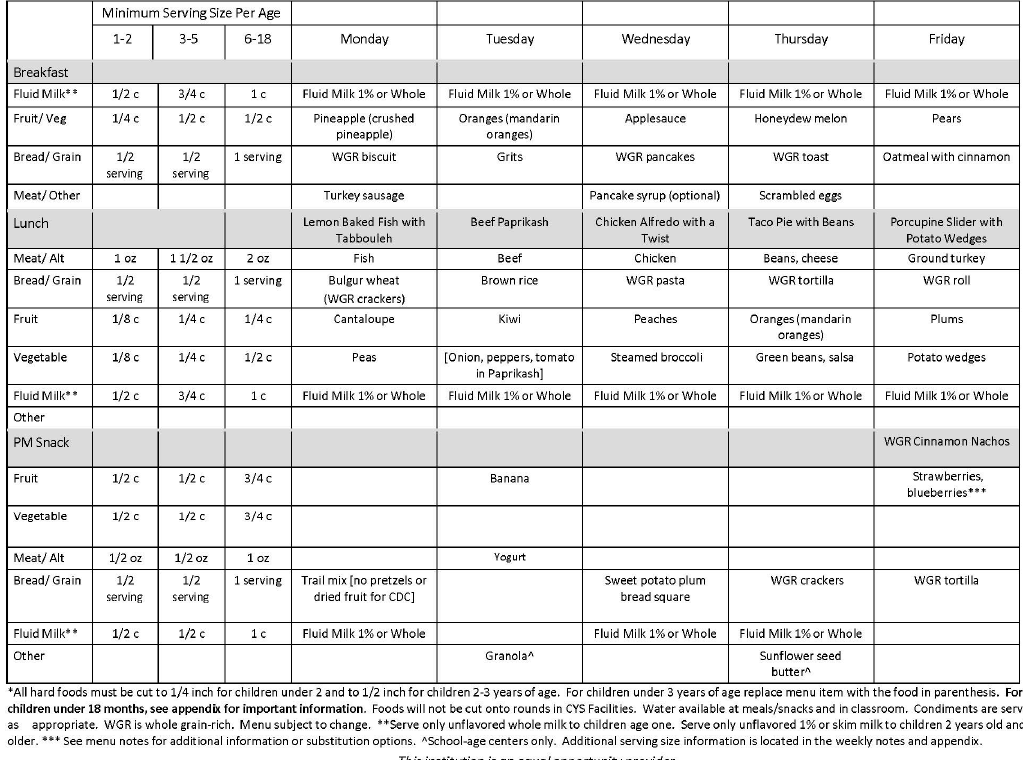
Figure 1. Sample week of the pilot menu for the Healthy Menu Initiative.